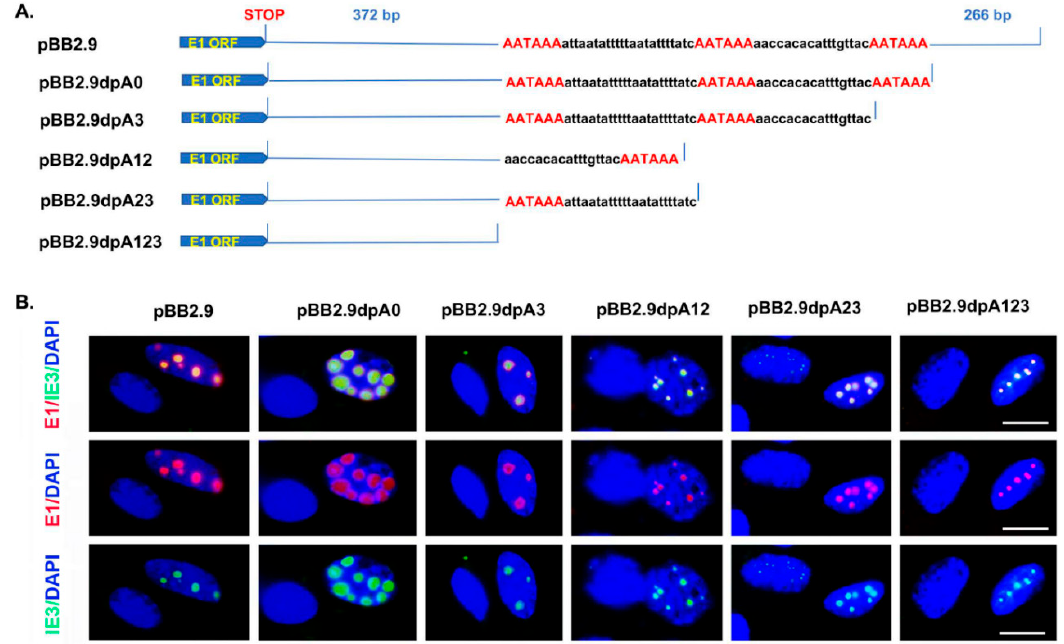
Figure 1. Construction of plasmids with mutation of the poly(A) signal cluster. ( A ) The diagram of the M112-113 gene and resultant mutations at the end of the M112-113 gene. E1 ORF stands for M112-113 coding open reading frame. Red words represent the poly(A) signal in the 3 (cid:48) terminus of the M112-113 gene. ( B ). Immunofluorescent assay to show M112-113 and GFPIE3 proteins after cotransfection of M112-113 expressing plasmids with GFPIE3-expressing plasmid for 24 h in NIH3T3 cells. M112-113 protein is stained with Texas red (TR) and IE3 is shown in green. Scale bar: 10 µm.